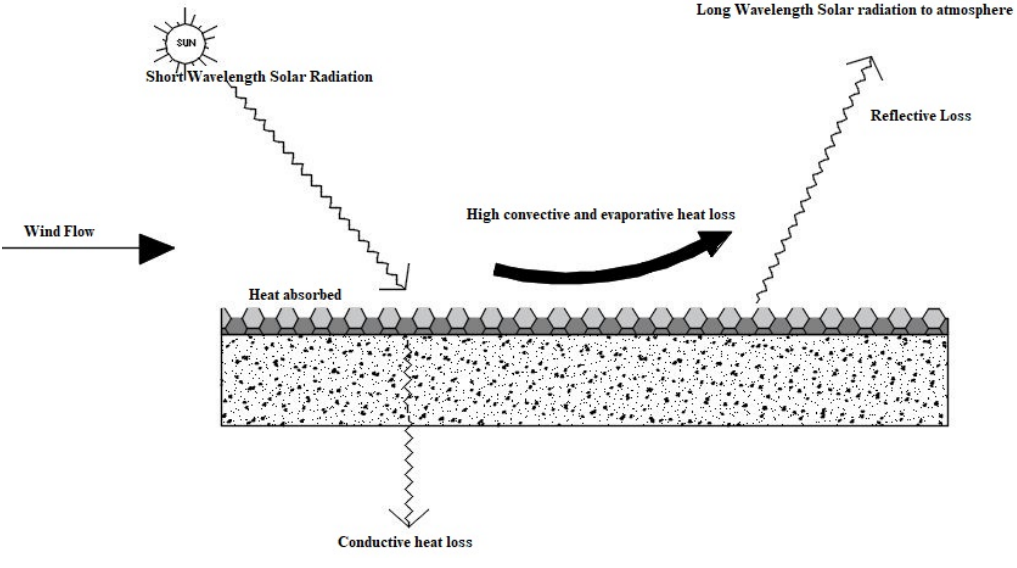
Figure 1. Open sun drying